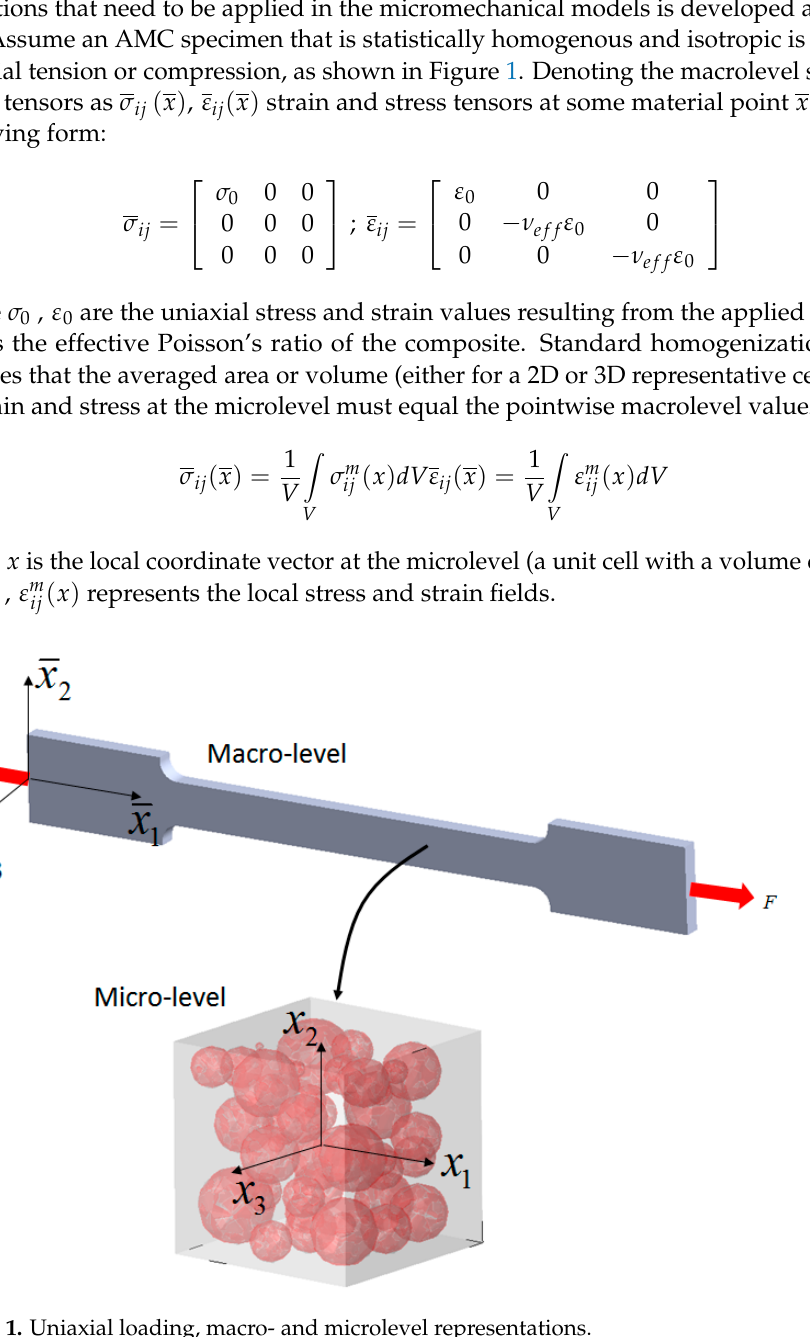
Figure 1. Uniaxial loading, macro- and microlevel representations.